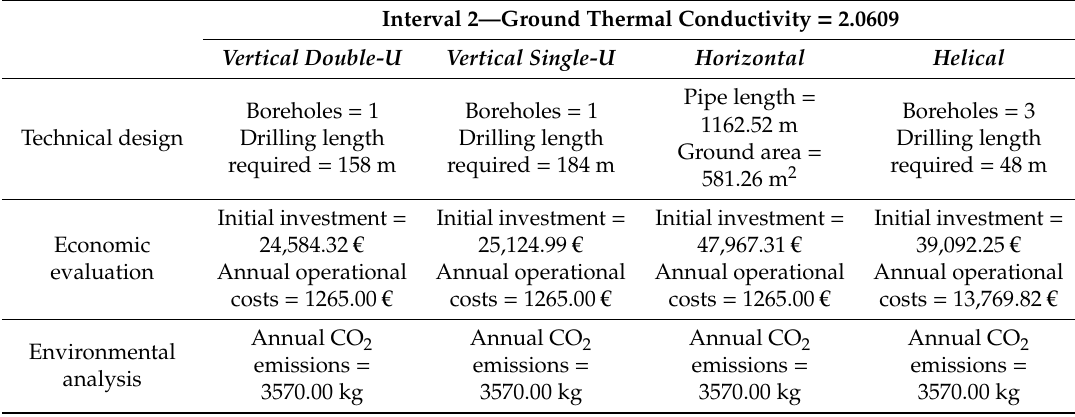
Table 6. Design provided by GES-CAL software for the geothermal system under study, interval